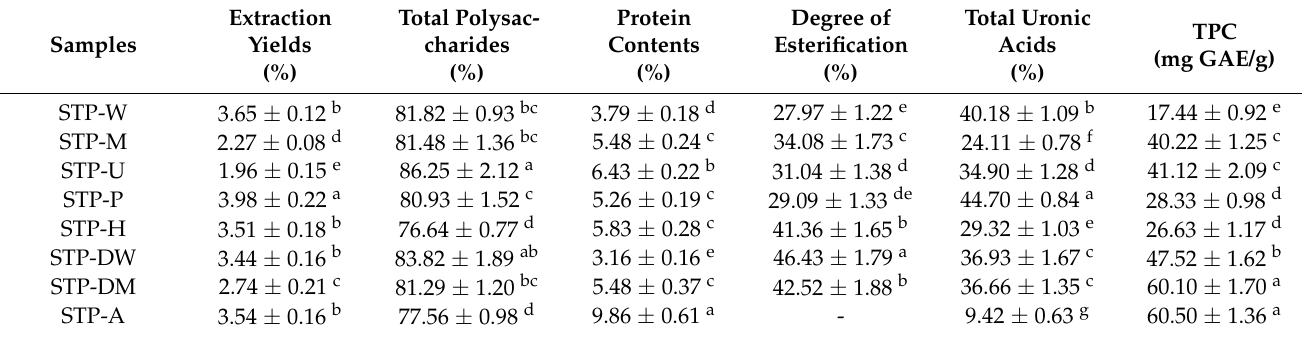
Table 1. Chemical compositions of STPs extracted by different